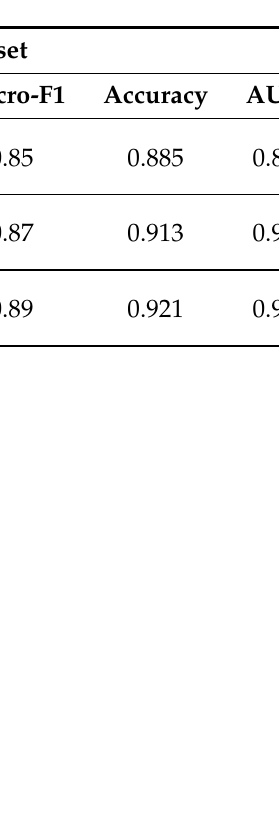
Table 5. Augmented dataset—Experiment 3 confusion matrix.